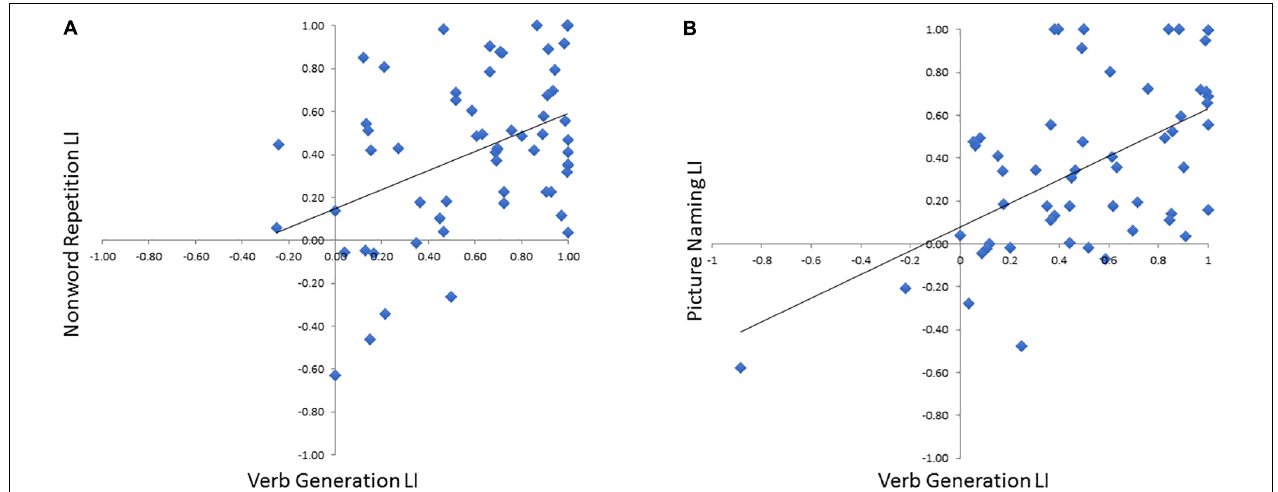
FIGURE 5 | Correlations between VG LI for each subject with LI scores derived from NWR (A) and PN (B) .